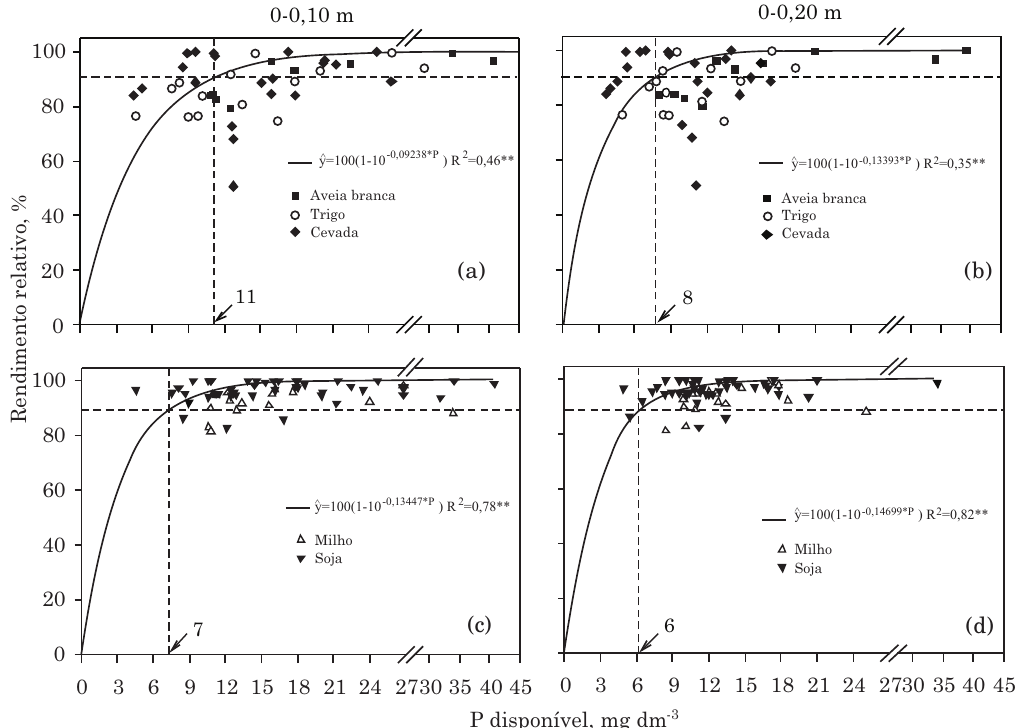
Figura 4. Rendimento relativo de aveia branca, trigo e cevada (a, b) e milho e soja (c, d) em razão do fósforo disponível (Mehlich-1), nas camadas de 0-0,10 e 0-0,20 m de solos em plantio direto na região Centro-Sul do Paraná.